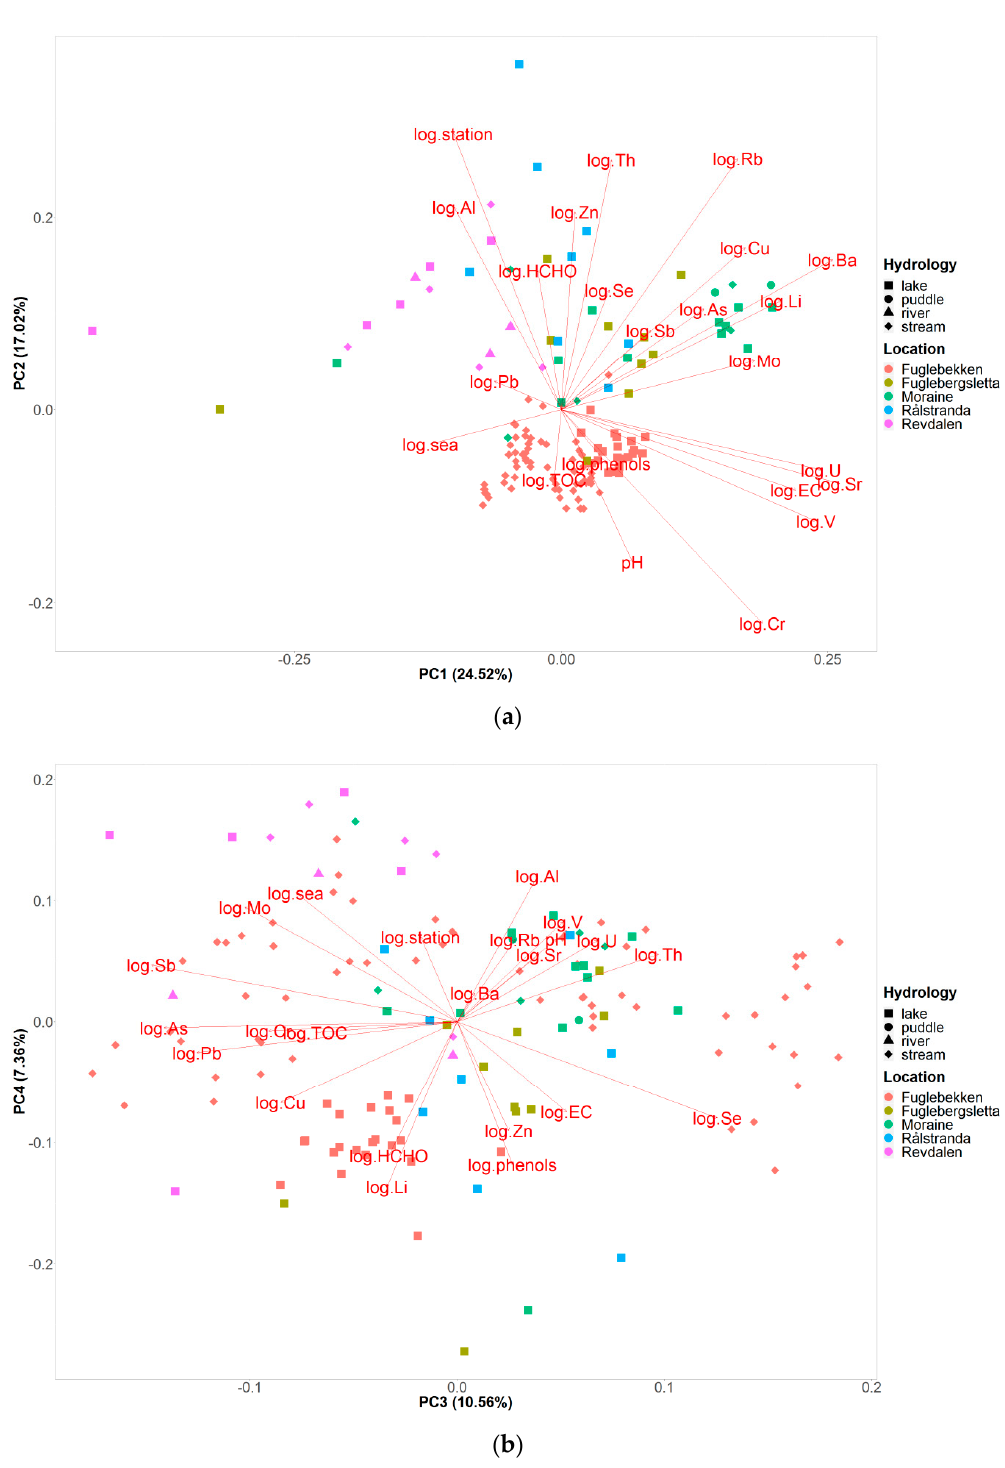
Figure 8. Principal component analysis (PCA) of the dataset consisting of EC, pH, and the concentrations of metals and metalloids, surfactants, TOC, formaldehyde and the sum of phenols, with distances from the Polish Polar Station (PSP) Hornsund and from the shoreline included. The variables are plotted in a space defined by: ( a ) pricinpal components (PCs) 1 and 2; ( b ) PCs 3 and 4. Color and shape of the points show their location and water body type.